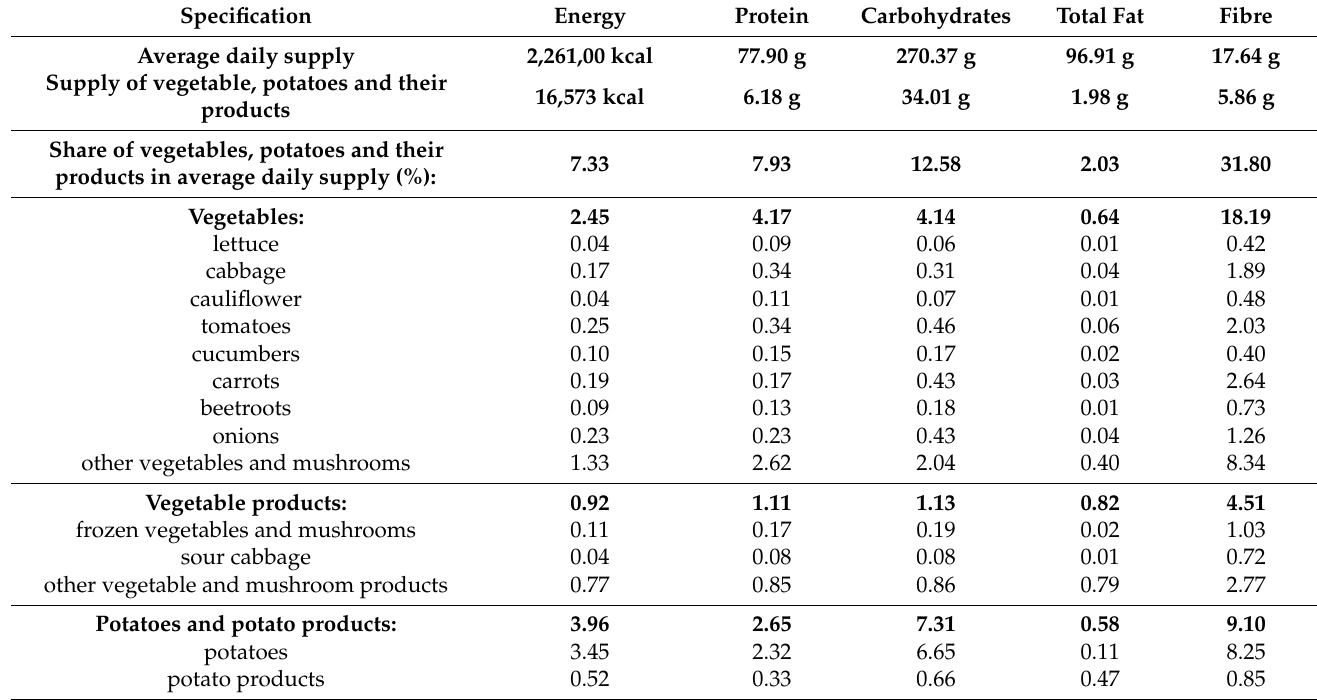
Table 2. Vegetables, potatoes, and their products as sources of energy, macronutrients, and fibre in the diet.